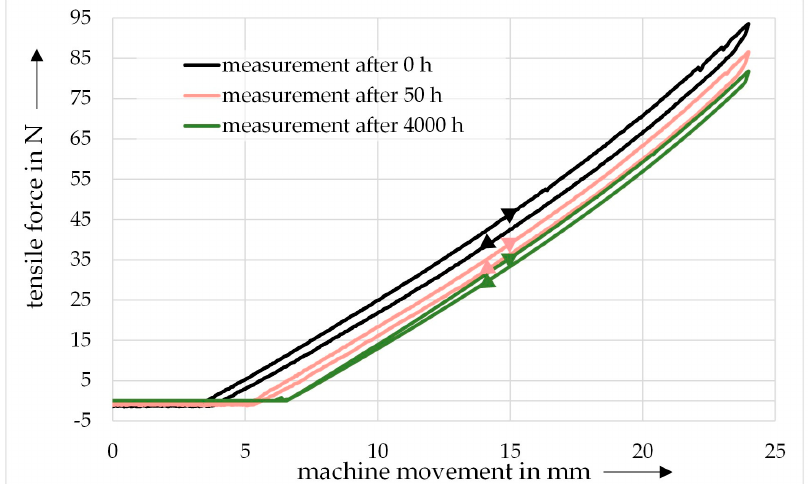
Figure 7. The tensile force depends on the machine movement of one sample stored mechanically installed at a temperature of 200 °C after three different load periods.